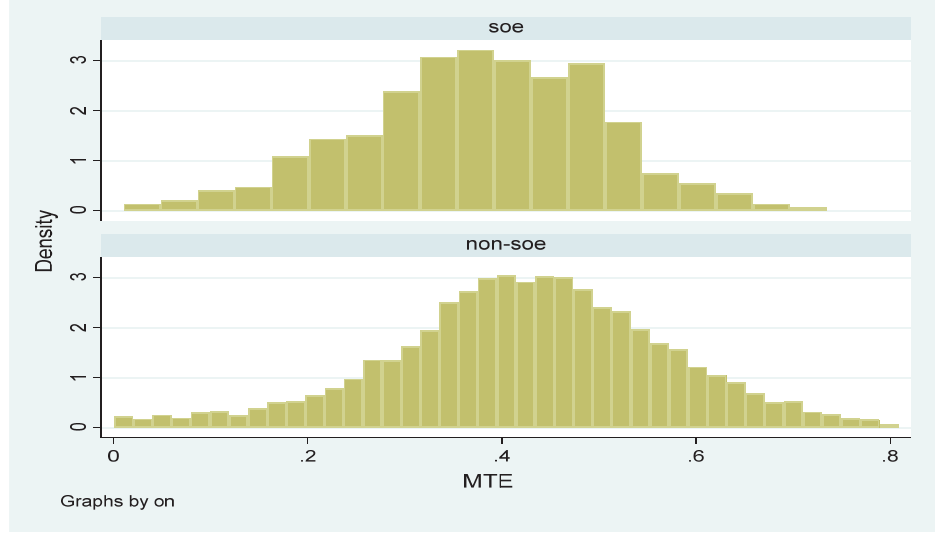
Fig. 1. The MTE for SOE and for non-SOE firms in 2016